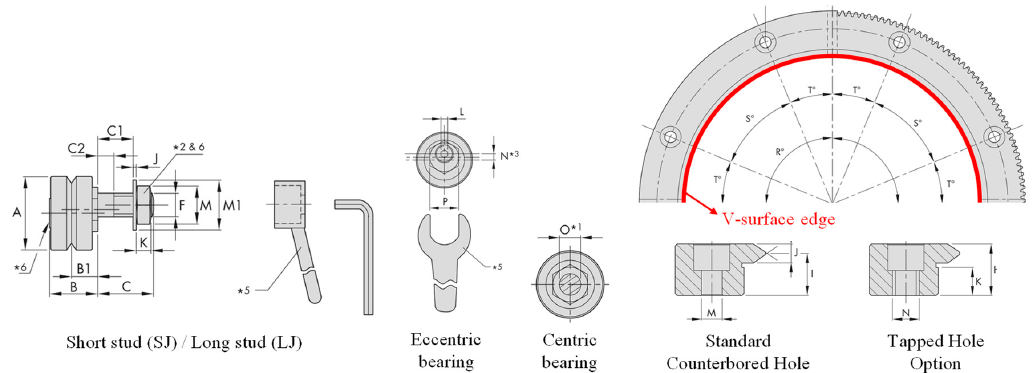
Figure 4. V-bearings of the single-edge ring system and circular motion slide system.